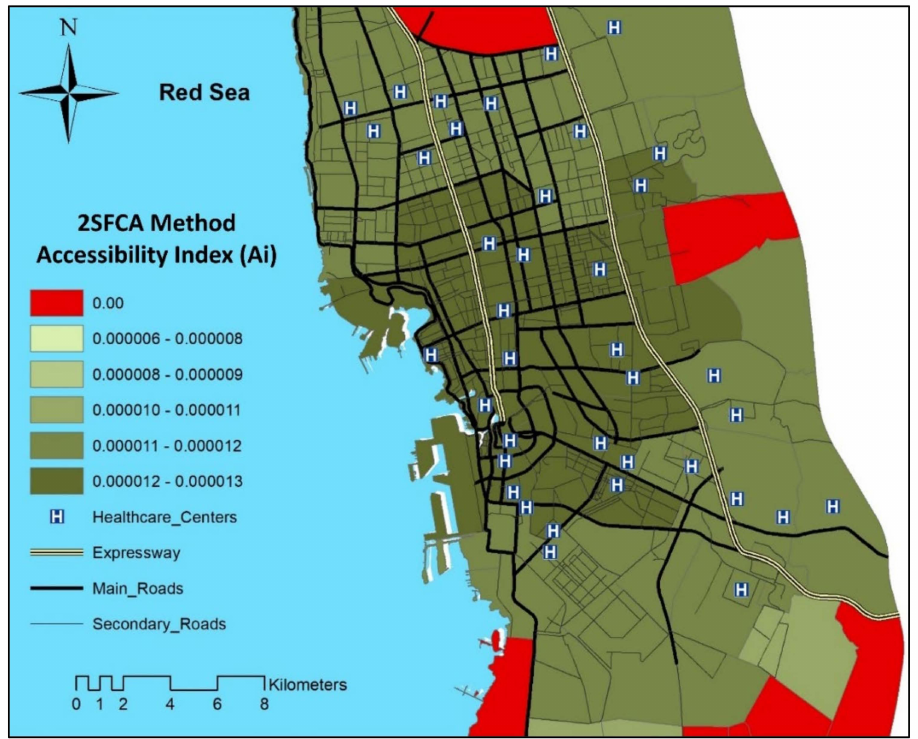
Figure 5. Districts with the greatest accessibility and their relationship to healthcare centers and road ne work. Note: The local road level was excluded from this map.